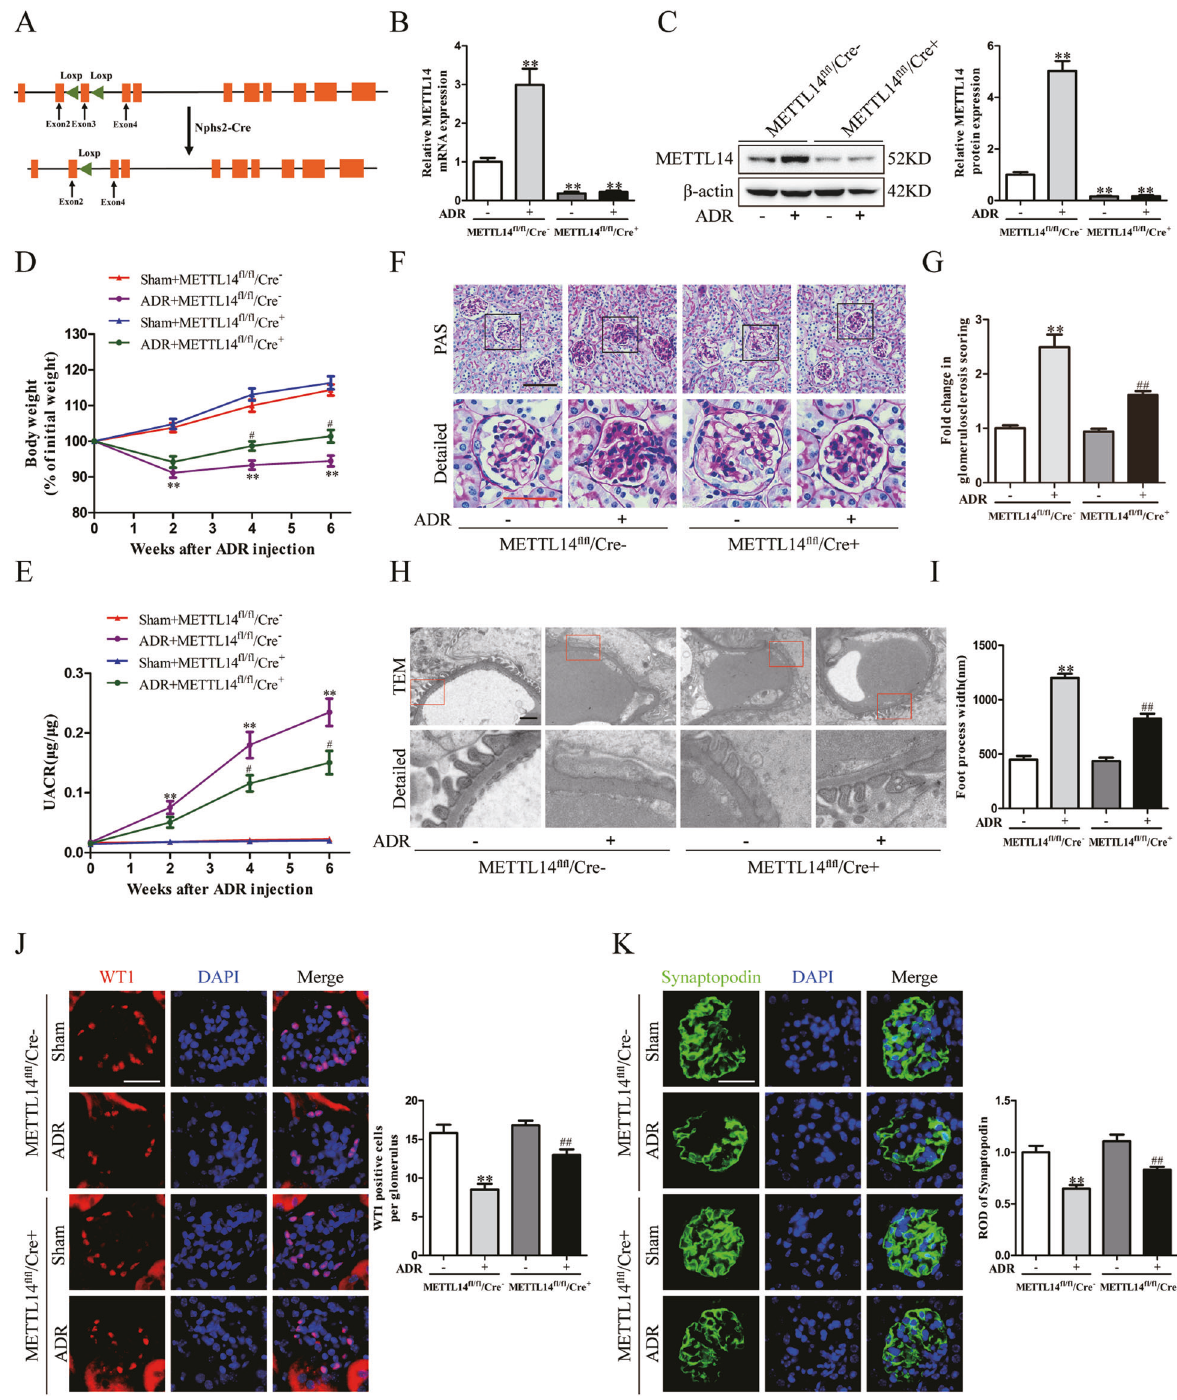
Fig. 3 Podocyte-selective deletion of METTL14 alleviated ADR-induced glomerular injury in vivo. Wild-type (METTL14 fl / fl /Cre − ) mice and podocyte-speci fi c METTL14 knockout (METTL14 fl / fl /Cre + ) mice were injected with saline or ADR (19.5 mg/kg). A The diagram depicting generation of METTL14 fl / fl /Cre + mice. Exon 3 of METTL14 gene were deleted in podocytes using Cre – LoxP recombination system. B The relative mRNA levels of METTL14 in isolated glomeruli from different groups of mice ( n = 4). C Representative immunoblots and quantitative analysis showing the evident decreased protein levels of METTL14 in isolated glomeruli from METTL14 fl / fl /Cre + mice with ADR injection ( n = 4). D Quantitative analysis of body weight in different groups of mice ( n = 6). E UACR (urine albumin-to creatinine ratio) in each group ( n = 6). F Representative images of PAS staining on kidney sections in different groups of mice. Scale bar: black 40 μ m, red 20 μ m. G Assessment of morphologic injury quanti fi ed with messangial matrix expansion in each group ( n = 6). H Representative transmission electron microscopy images of podocyte foot process in different groups of mice. Scale bar, 1 μ m. I Quantitative analysis of podocyte foot process effacement and GBM thickness in the four groups ( n = 6). J Representative images and quanti fi cation of immuno fl uorescence staining for WT1 on kidneys of each group. Scale bar, 20 μ m ( n = 6). K Representative images and quanti fi cation of immuno fl uorescence staining for synaptopodin on kidneys of each group. Scale bar, 20 μ m ( n = 6). ** P < 0.01 vs. METTL14 fl / fl /Cre − mice injected with saline, # P < 0.05, ## P < 0.01 vs. METTL14 fl / fl /Cre − mice with ADR injection. Data are presented as mean ±